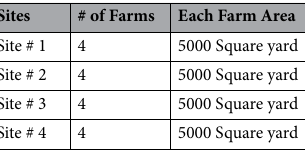
Table 5. List of candidate test sites for proposed